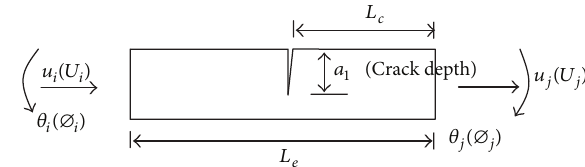
Figure 5: View of a crack beam element subjected to axial and bending